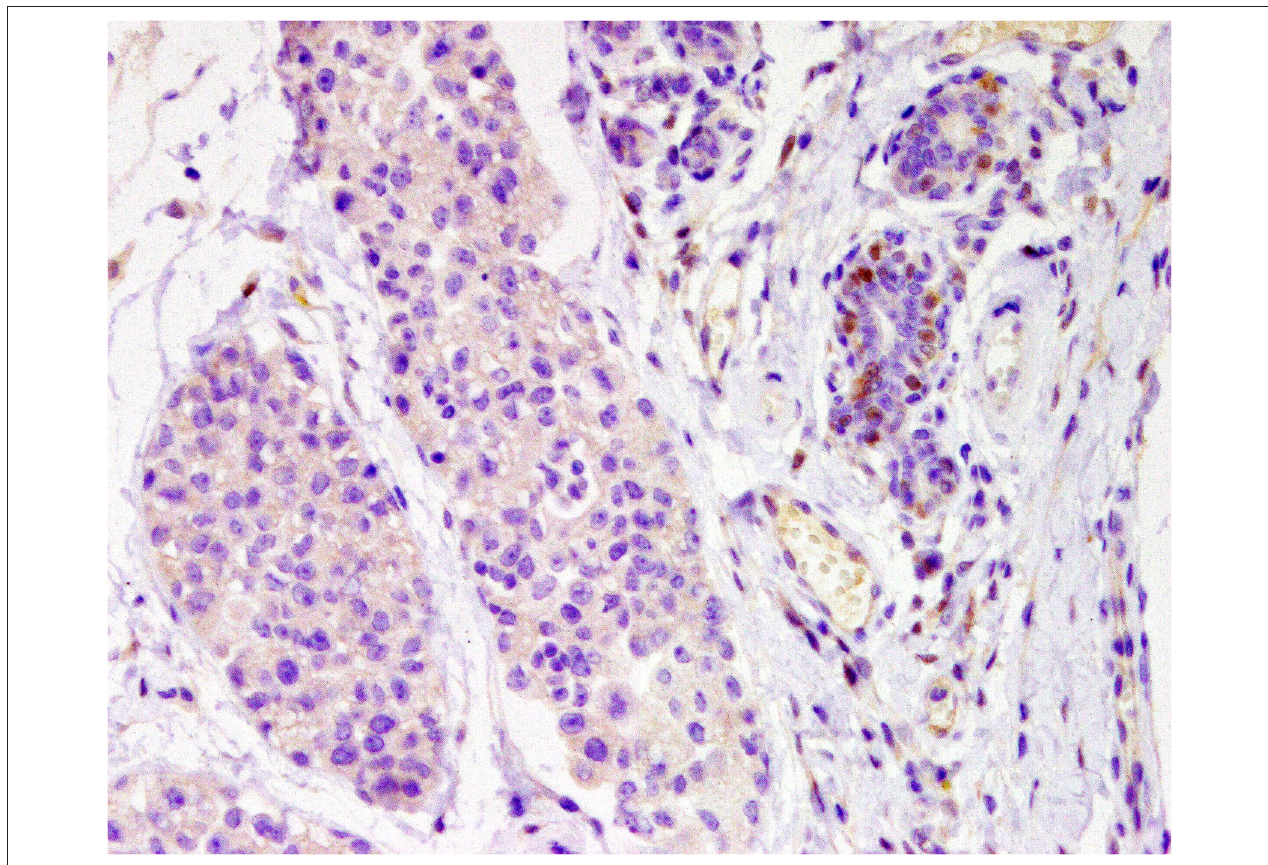
FIGURE 9 | Tubular carcinoma, mammary gland, dog. Immunohistochemical nuclear staining of androgen receptor (AR). Neoplastic cells are negative; adjacent mammary hyperplastic cells are